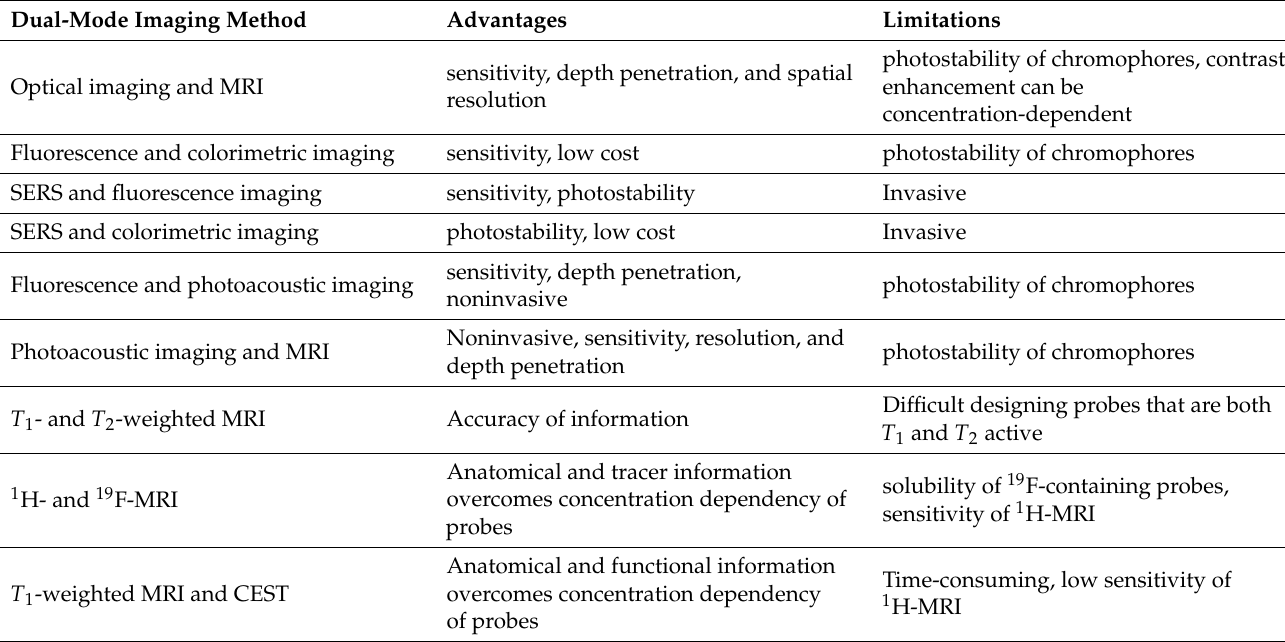
Table 4. Summary of dual-mode hypoxia-responsive